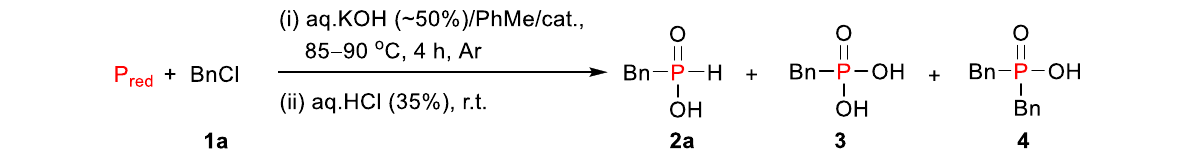
Table 1. Catalyst screening in the phosphinylation of benzyl chloride 1a with red phosphorus 1